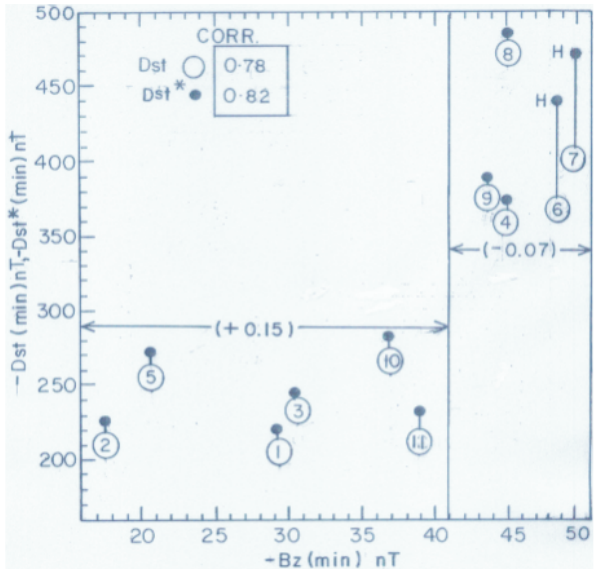
Fig. 5. Plots of maximum negative magnitudes of Dst versus (a) maximum negative magnitudes of B z , (b) B z (CP), (c) V B z and (d) V B z (CP). Corresponding correlations are